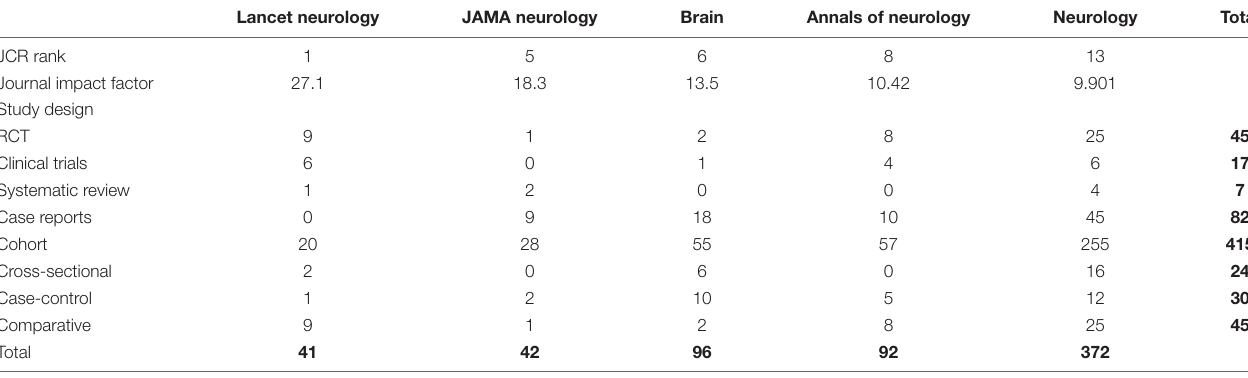
FIGURE 1 | Estimated ratio of number of publications per year for each subspecialty compared to neurology within each journal ( N = 250 combinations of year, journal, subspecialty). Estimates are shown with 95% confidence intervals adjusted for multiple testing. ENDO, Endocrinology; GI, Gastroenterology; RESP, Respirology. TABLE 3 | Productivity of the top 5 neurology journals with distribution by journal and by study design.